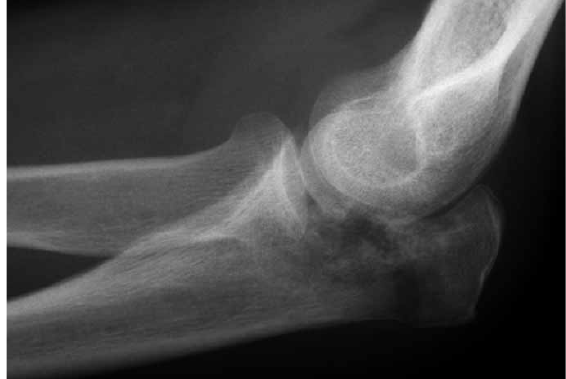
Figure 1. Lateral Radiograph elbow. This shows a pathological fracture of the olecranon. Features are that of an aggressive lesion but are otherwise non-specific.